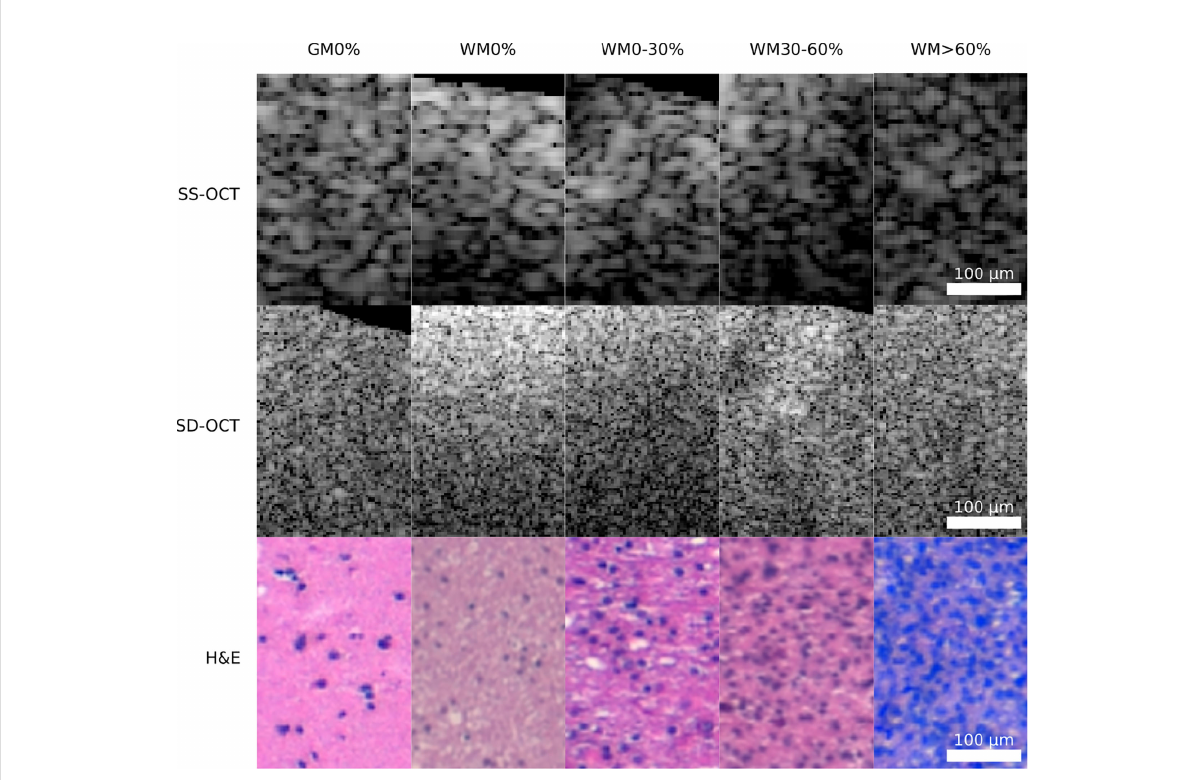
FIGURE 3 Example patches of each OCT-system for the fi ve different tissue types (GM0%, gray matter 0% tumor in fi ltration; WM0%, white matter 0% tumor in fi ltration; WM0 – 30%, white matter with 0 – 30% tumor in fi ltration; WM30 – 60%, white matter with 30 – 60% tumor in fi ltration; WM >60%, white matter with >60% tumor in fi